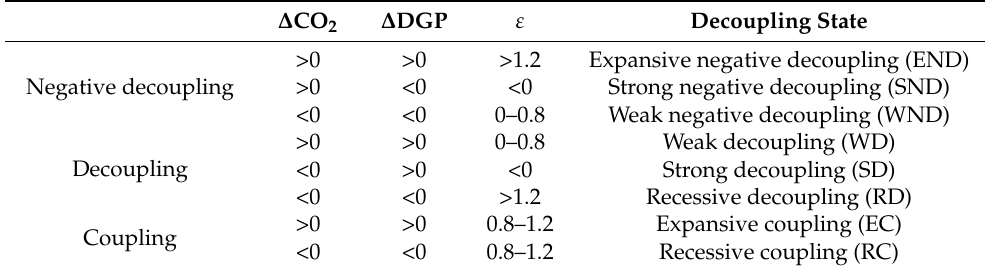
Table 3. The degrees of coupling and